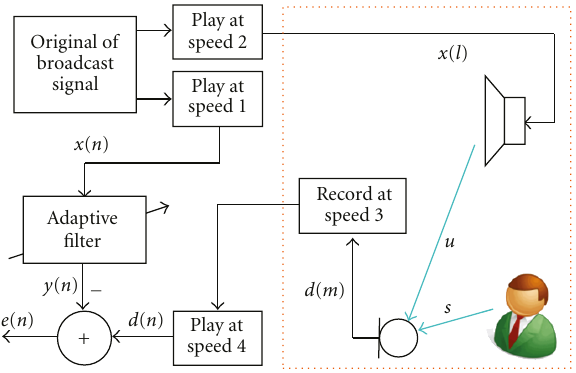
Figure 2: Adaptive interference cancellation with asynchronous primary and reference